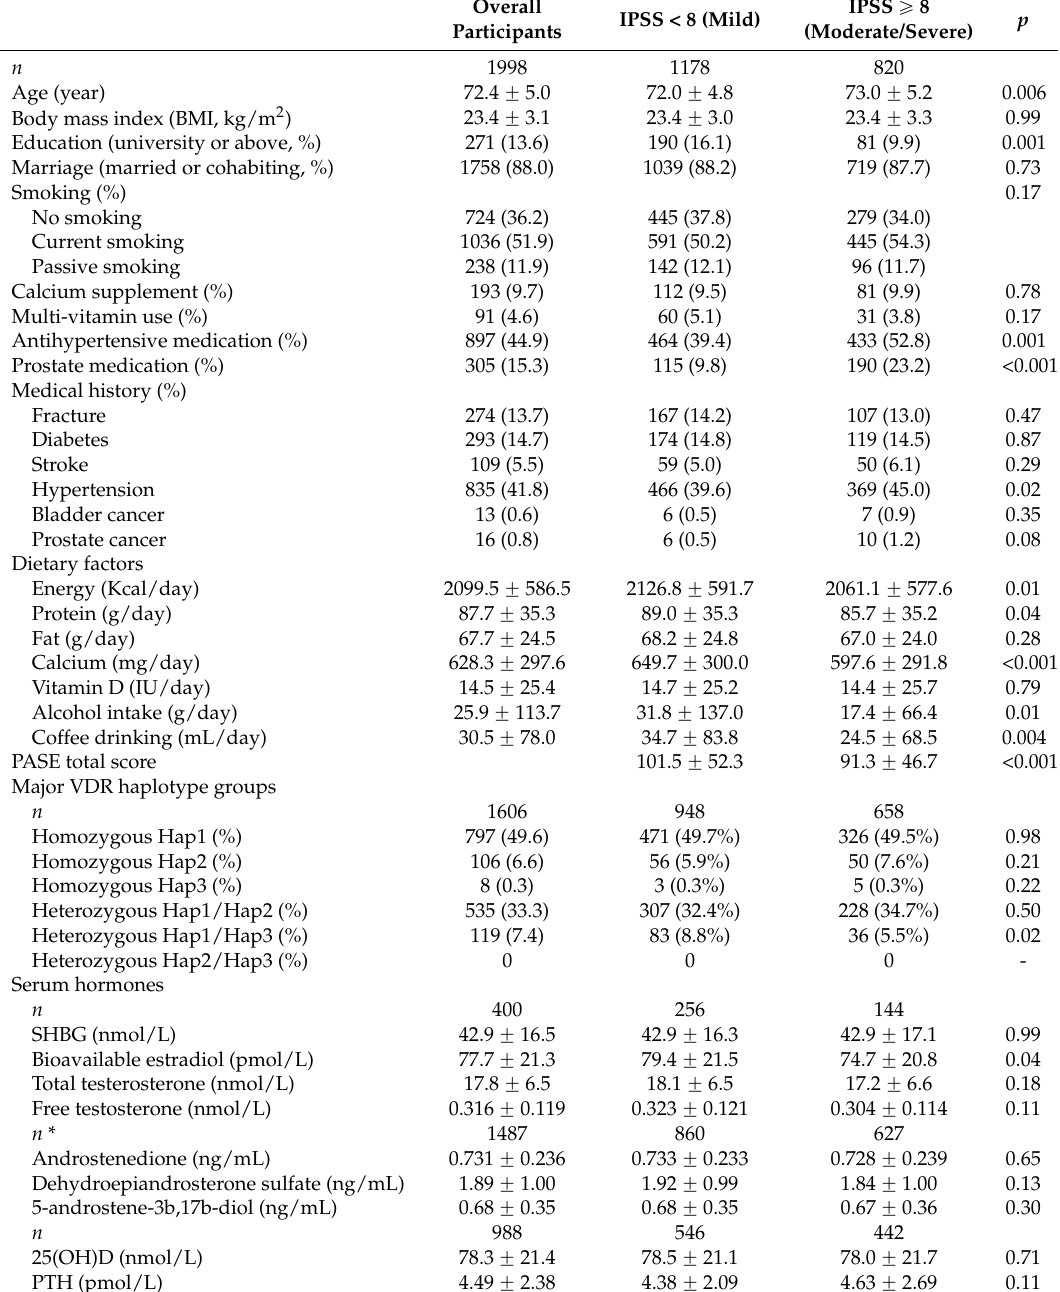
Table 1. Participants’ characteristics at